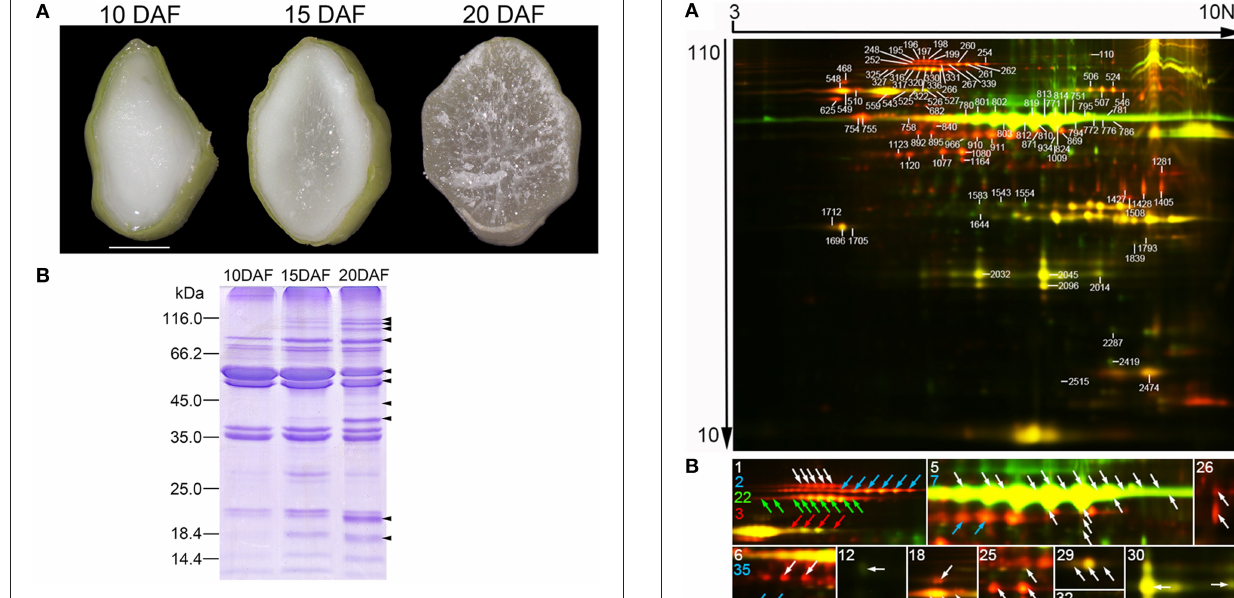
FIGURE 1 | Cellular features of rice endosperms at 10, 15, and 20 days after flowering (DAF) and sodium dodecyl sulfate-polyacrylamide gel electrophoresis (SDS-PAGE) patterns of starch granule associated proteins (SGAPs) of the endosperms. (A) Transverse images of endosperms at 10, 15, and 20 DAF. Scale bar = 1.5 mm. (B) SDS-PAGE patterns of SGAPs from starch granules prepared from endosperms at the three stages. Arrows showing protein bands obviously changed during endosperm development.